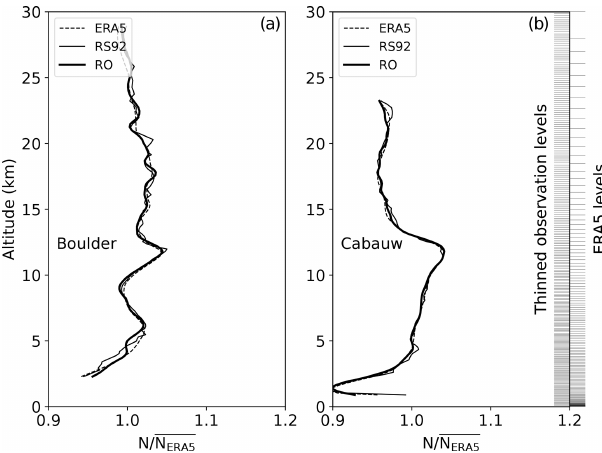
Figure 2. Refractivity of two selected triple collocations exem- plifying differences in vertical footprint. (a) ERA5, RS92, and COSMIC-1 RO (40.1 ◦ N, collocation distance: 18.6km (0.2h)) and (b) ERA5, RS92, and Metop RO (52 ◦ N, collocation distance: 25.5km (1.6h)). RS92 and ERA5 have been interpolated to the 247 RO height levels. The refractivity has been normalized by division with the mean of the ERA5 data set refractivity. The thinned refrac- tivity levels and the 137 ERA5 model levels are printed on the right vertical